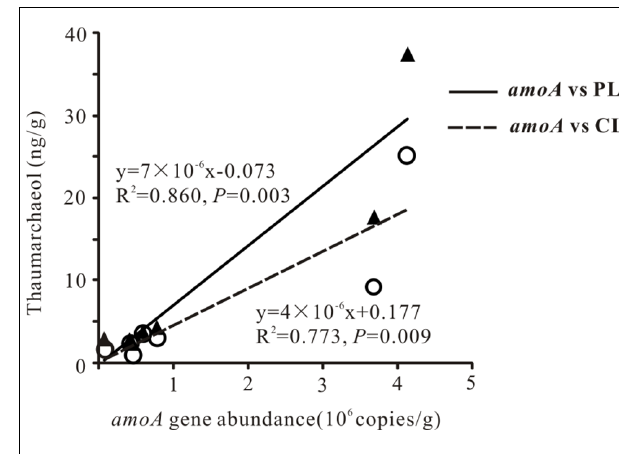
FIGURE 3 | Scatter plot showing a correlation between sediment amoA gene copies and